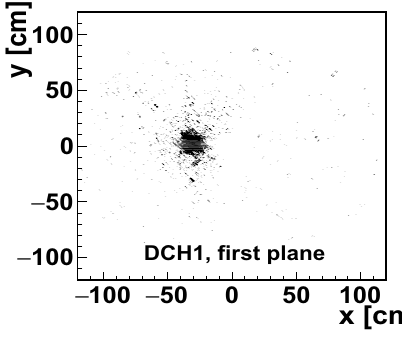
Figure 2. Profile of the carbon beam at E kin = 4 . 5